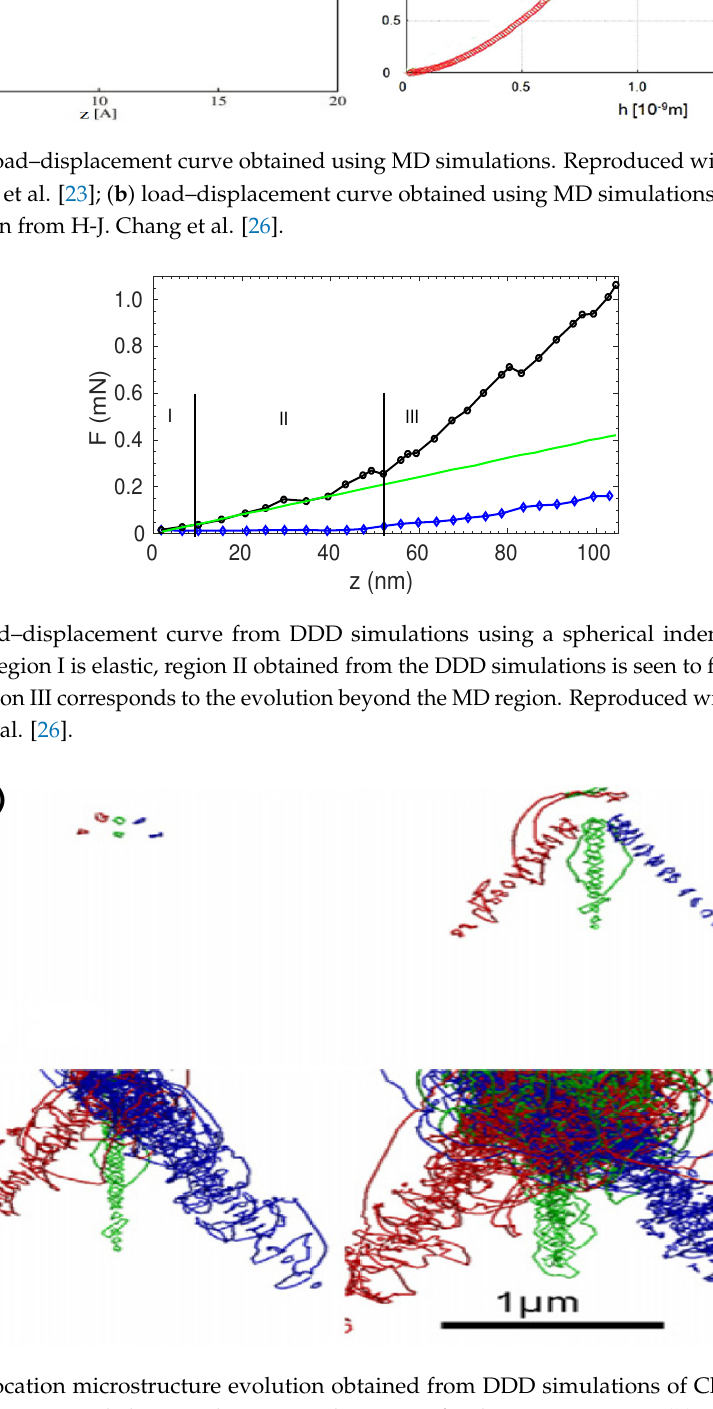
Figure 3. Dislocation microstructure evolution obtained from DDD simulations of Chang et al. ( a ) Nucleation of prismatic dislocation loops at early stages of indentation process. ( b ) Propagation of nucleated dislocation loops followed by initial stages of multiplication. ( c ), ( d ) Further multiplication of dislocations and formation of junctions. Reproduced with permission from Chang et al.